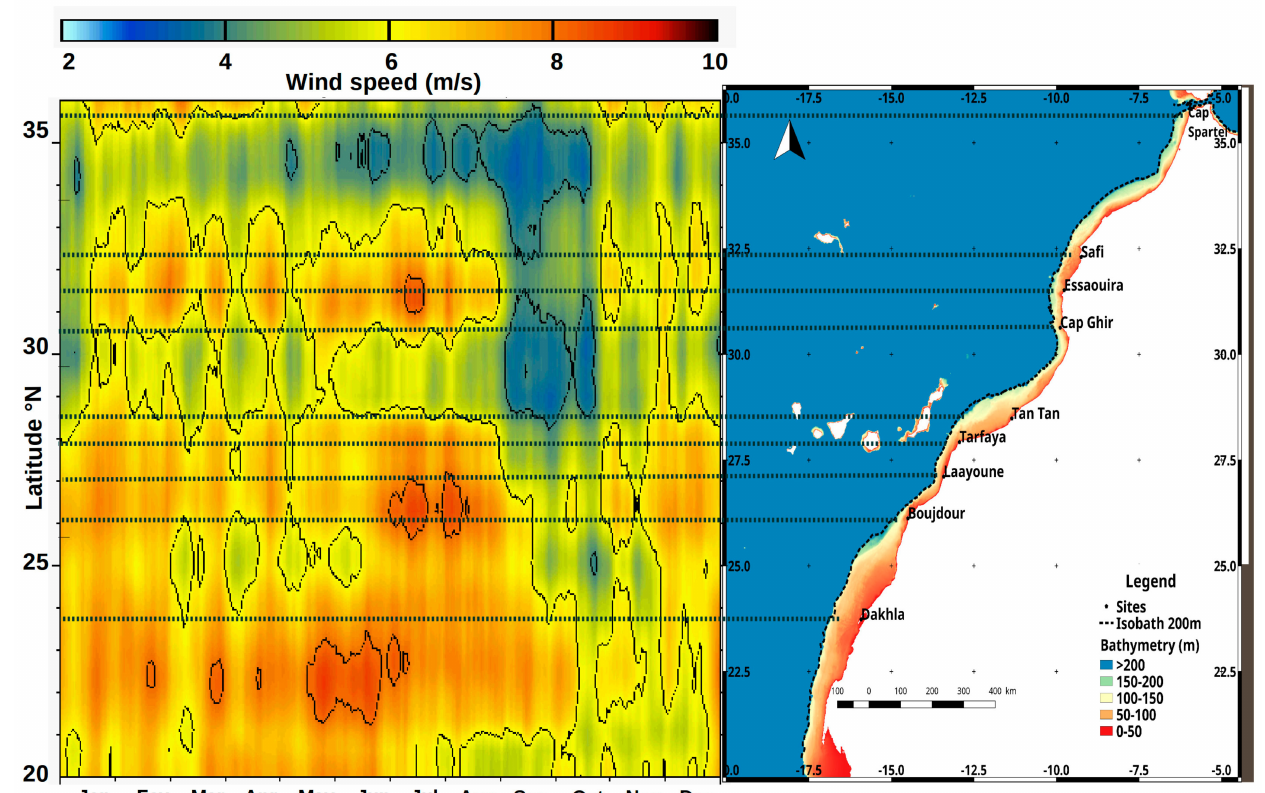
Figure 4. Hovmoller diagram of the climatological ASCAT wind intensity with a spatial resolution of 0.25 degrees and daily time step along the entire Moroccan area at 10 m height a.s.l; the dashed lines denote the sites sampled and considered for an assessment of the energy